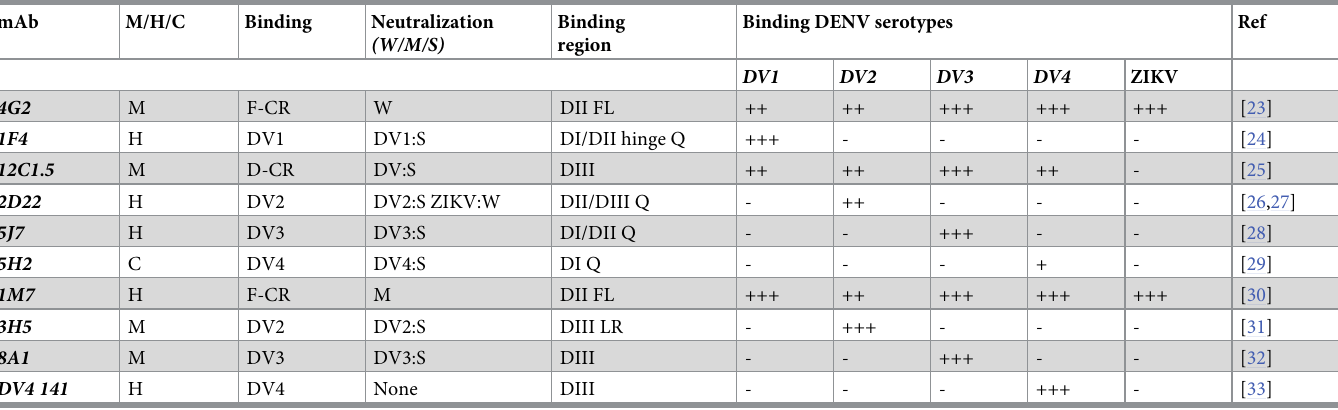
Table 1. Dengue specific monoclonal antibodies.